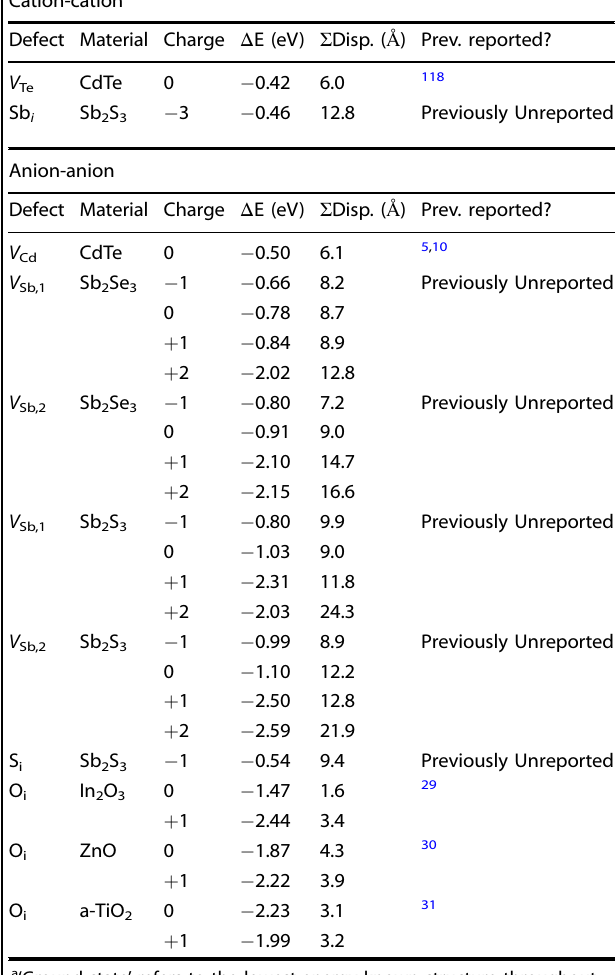
shown in Supplementary Figs. 10 –